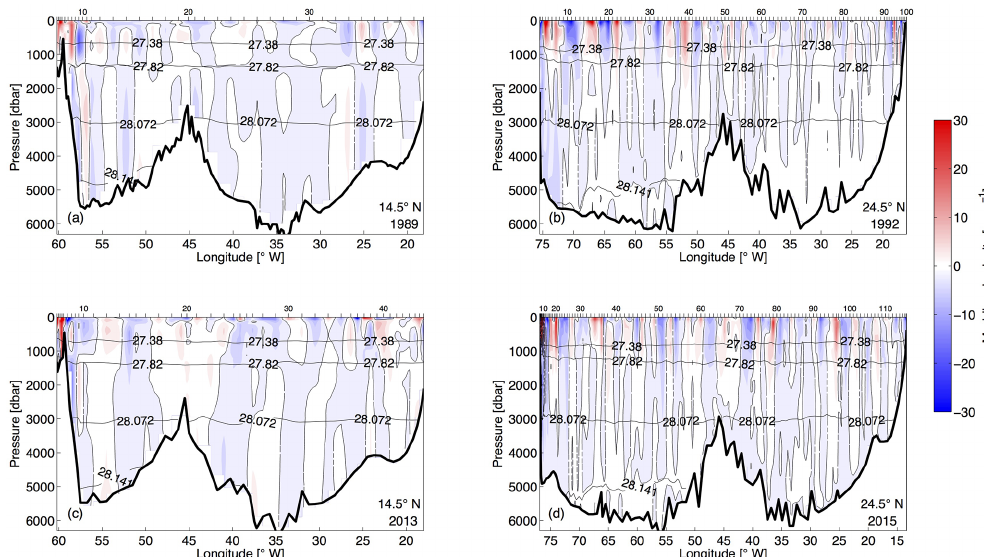
Figure 12. Absolute meridional geostrophic velocity along 14.5 ◦ N in (a) 1989 and (c) 2013 and along 24.5 ◦ N in (b) 1992 and (d) 2015. The station pair number is marked on the top horizontal axis. The black dashed contour line is the zero velocity contour. The black solid lines with values are the neutral density surfaces for the corresponding sections, which typically separate the thermocline water, AAIW, UNADW, LNADW, and